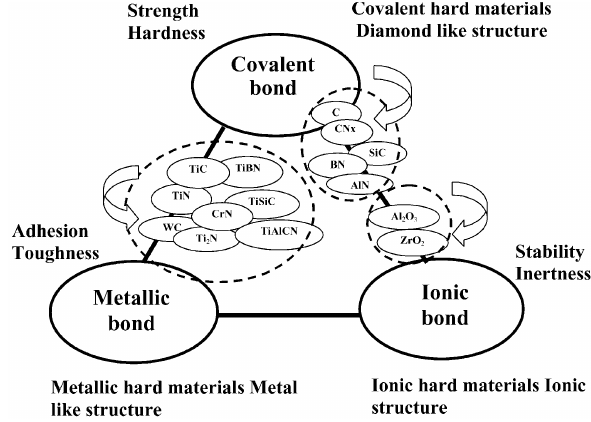
Figure 5: Hard materials in the bond triangle that affect the prop- erties due to change in chemical bonding in nanocomposite coat- ing